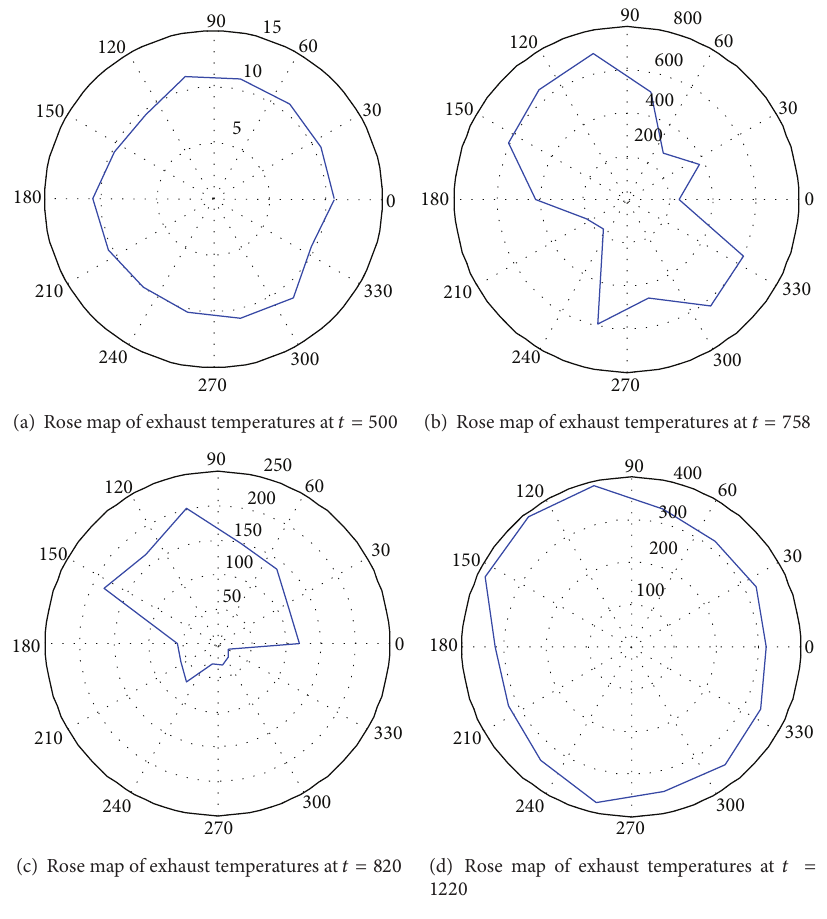
Figure 9: Samples of temperature distribution in different